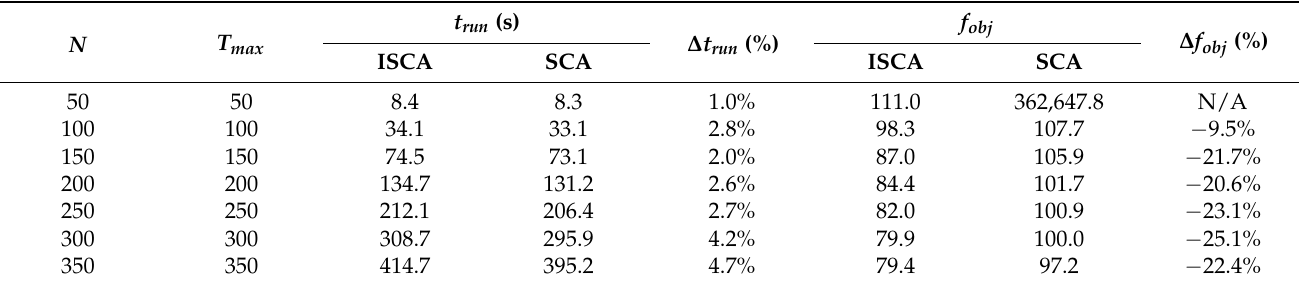
Table 2. Performance comparison between ISCA and